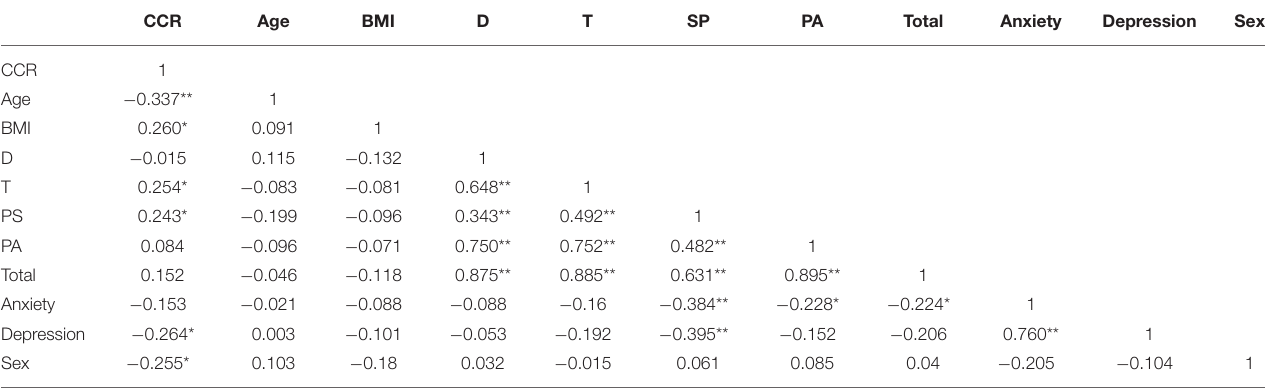
TABLE 3 | Analysis of the correlations of endogenous creatinine clearance and self-management with anxiety and depression.